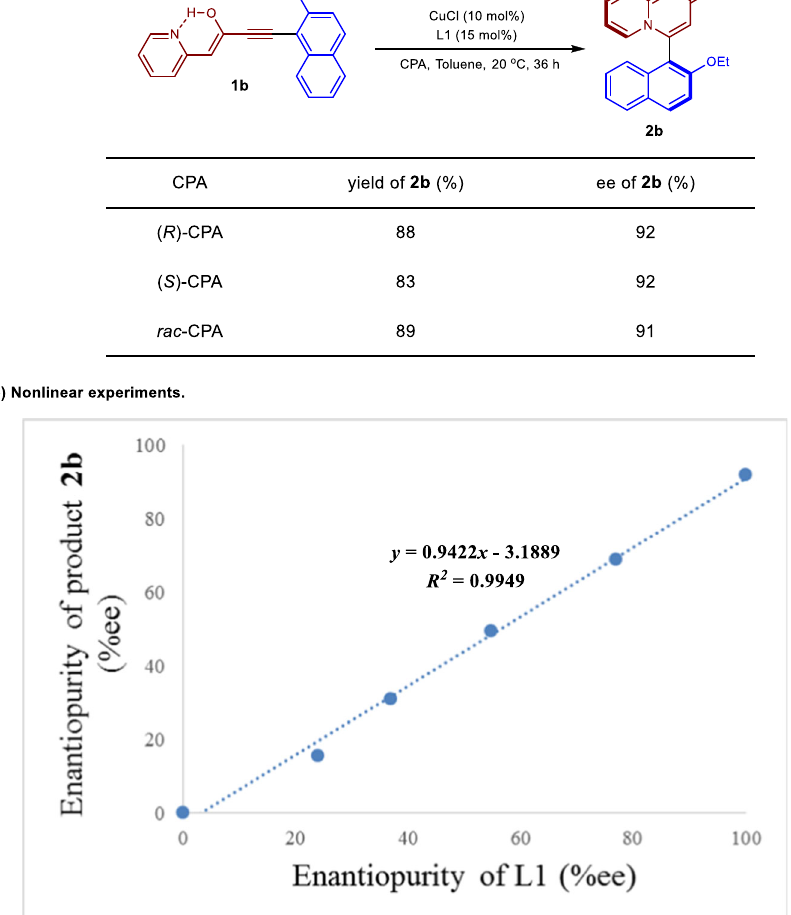
Fig. 4 Mechanistic studies of enantioselectivities of reaction. a Control experiments. b Nonlinear